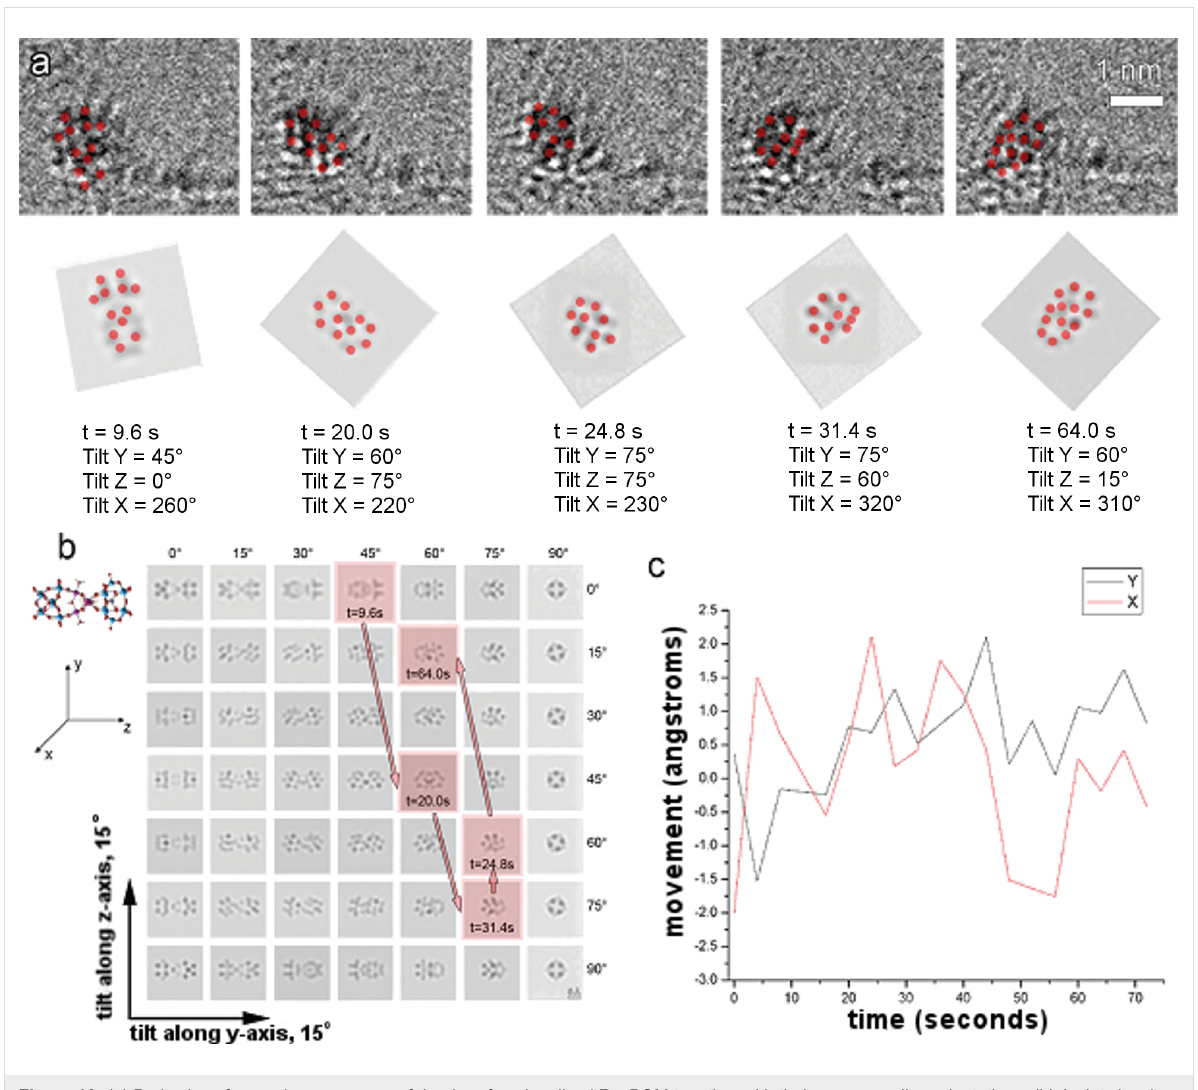
Figure 10: (a) Projections from a time sequence of dendron-functionalized Ru 4 POM together with their corresponding orientations. (b) A plot showing the orientation changes as highlighted by the red squares. The movement path is indicated by arrows. (c) A diagram showing 2D translation of Ru 4 POM with time. Reproduced with permission from [46], copyright 2013